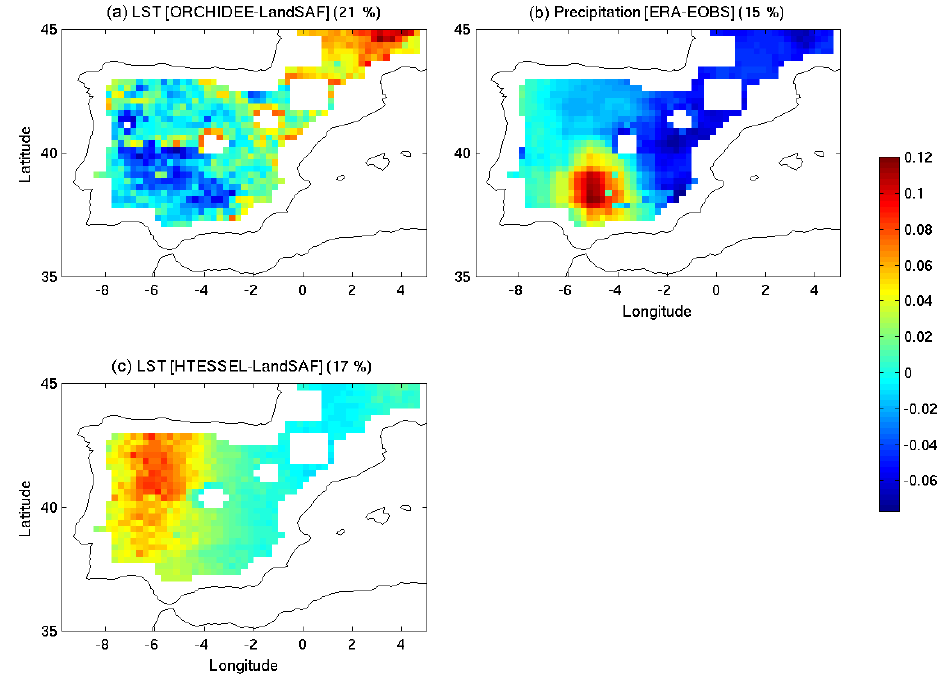
Figure 7. Spatial patterns from the first EOF variation mode of the LST and the precipitation errors. The percentage of variance explained by each mode is included in brackets.